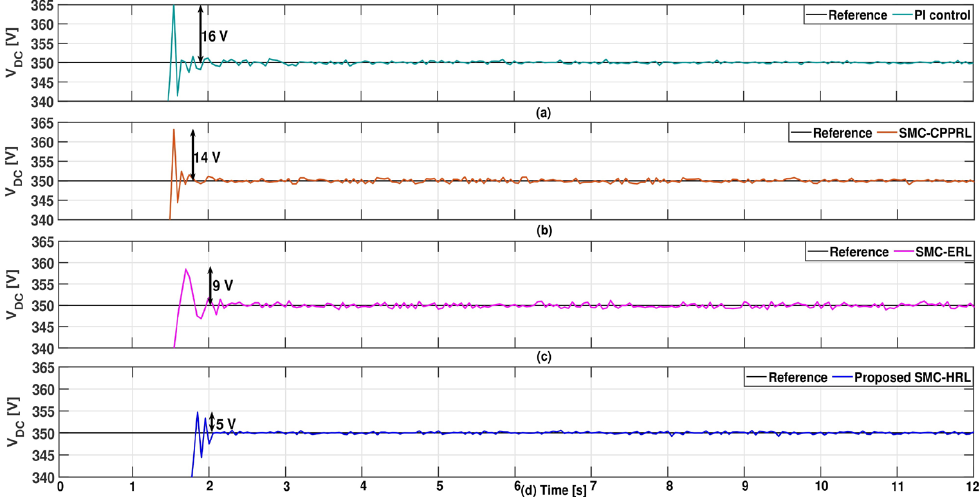
Figure 8. DC-link voltage responses in experiment for the system startup condition. ( a ) PI control.